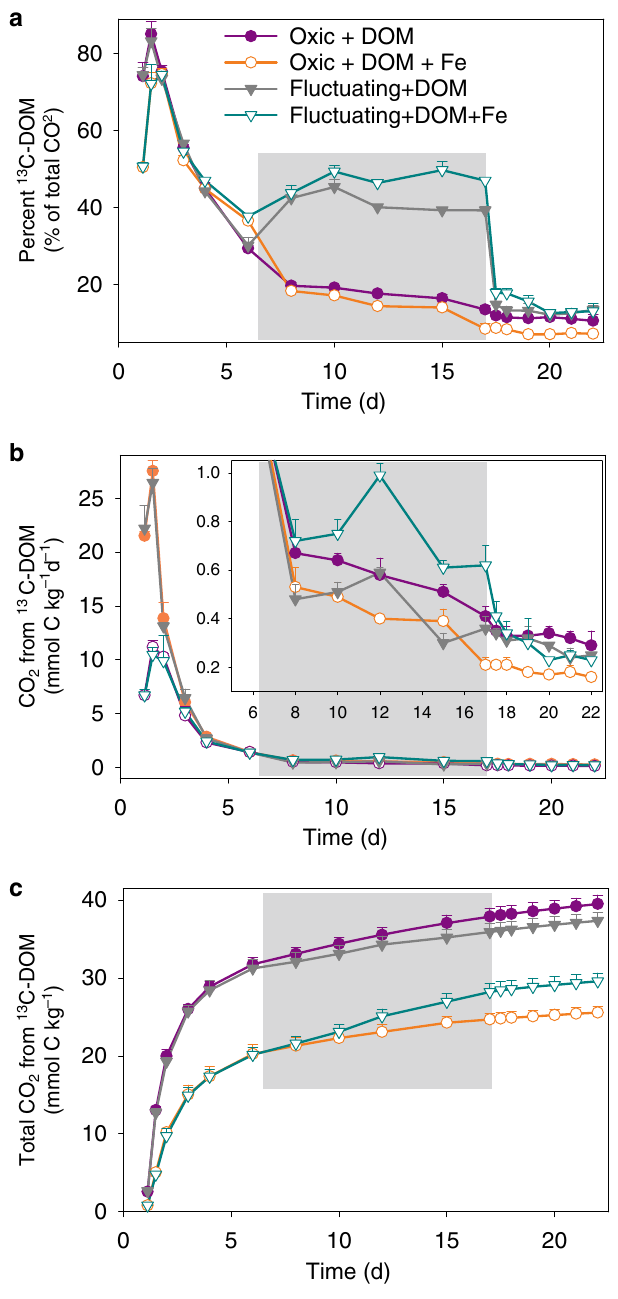
Fig. 4 Mineralization of the amended 13 C-labeled DOM. a The percent contribution of 13 C-labeled DOM to total CO 2 production, b CO 2 production rates from 13 C-labeled DOM, and c cumulative CO 2 production from 13 C- labeled DOM. The gray shaded region represents the anoxic phase of the redox- fl uctuating treatment. Error bars indicate s.e.m. ( n =